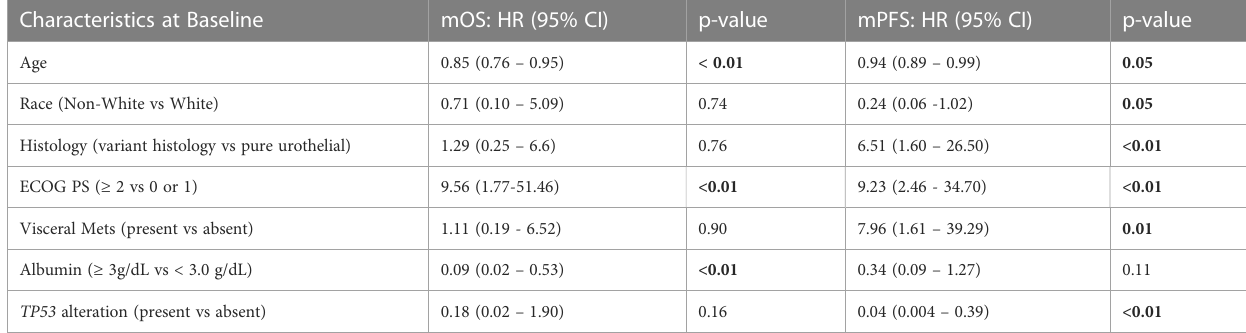
TABLE 3 Multivariable analysis of overall survival and progression free- survival with relevant clinical variables and TP53 alterations. Characteristics at Baseline